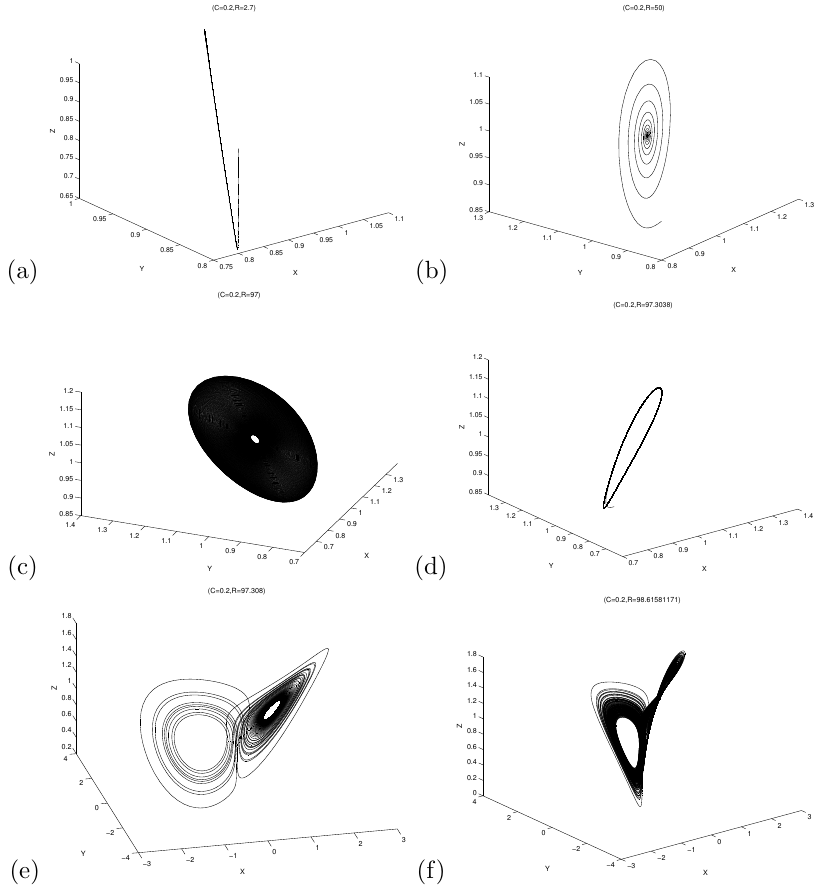
Figure 5. Computational results for the evolution of trajectories over time in the state space for increasing values of scaled Rayleigh number ( R ). The graphs represent the projection of the solution data points onto X - Y - Z plane for Pr = 10, λ = 8 / 3 and C = 0 . 2 for for (a) R = 2 . 7, (b) R = 50, (c) R = 97, (d) R = 97 . 3038, (e) R = 97 . 308, (f) R = 98 .